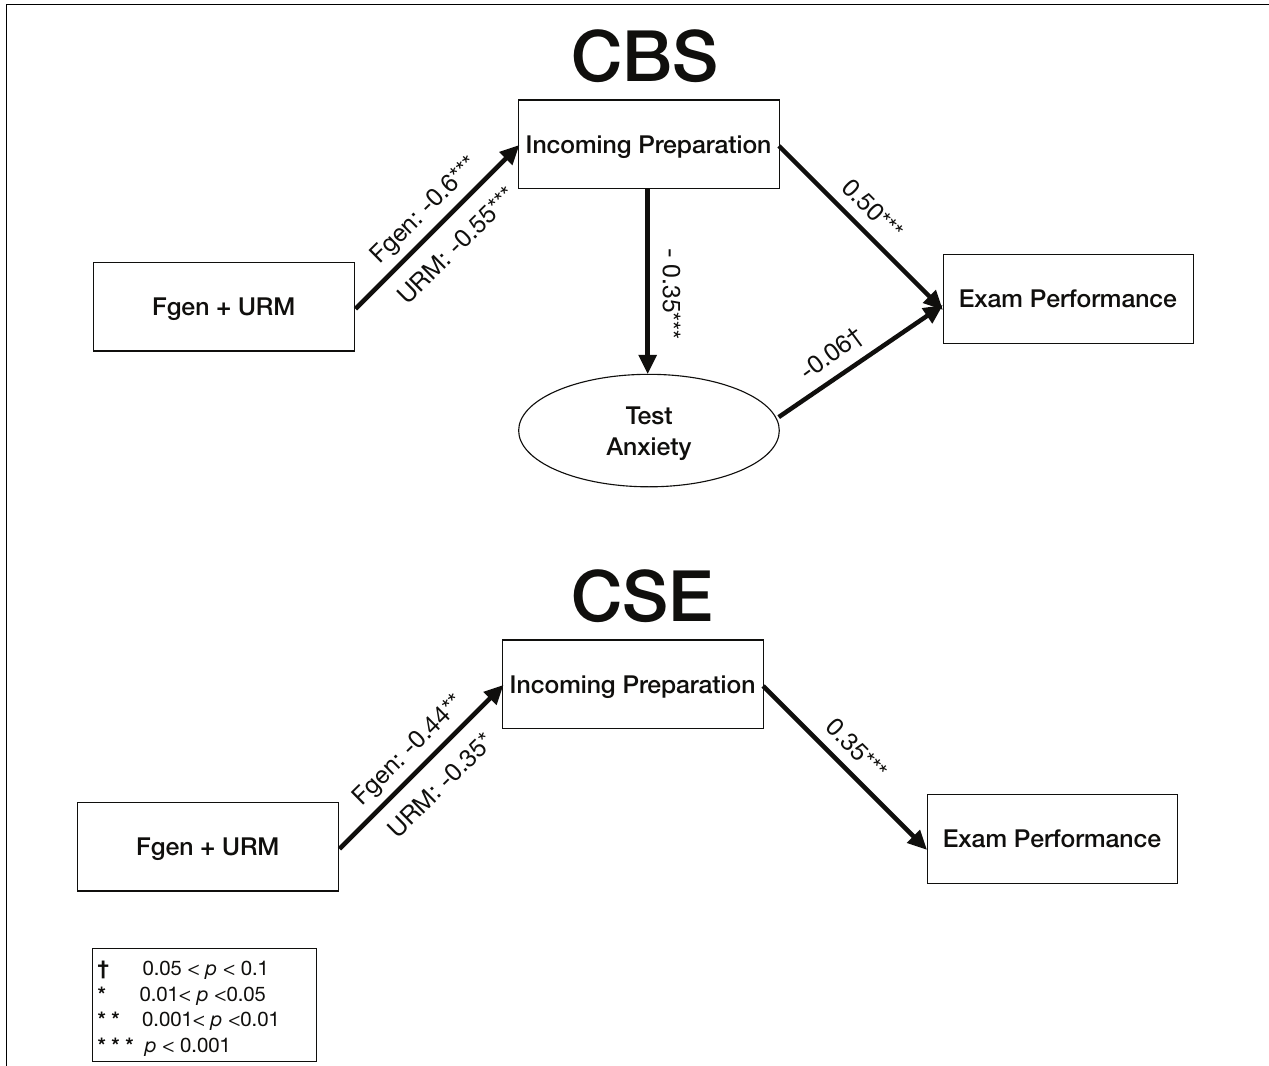
FIGURE 5 | Paths represent relationships between demographic status, incoming preparation, social psychological factors, and student exam performance for students enrolled in courses in the College of Biological Sciences (CBS) and the College of Science & Engineering (CSE). The numbers represent coefficients in standard deviation